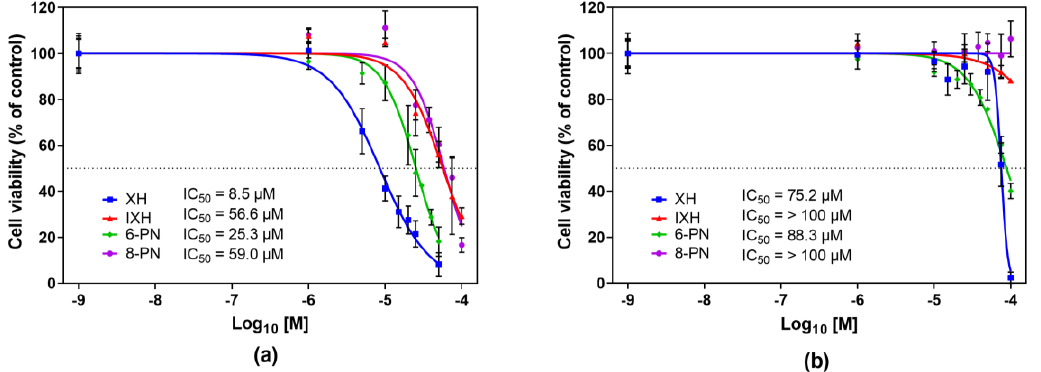
Figure 1. The e ff ect of xanthohumol, isoxanthohumol, 6-prenylnaringenin and 8-prenylnaringenin on the viability of proliferating ( a ) and di ff erentiated ( b ) CaCo-2 cells after a 24 h treatment. Cell viability was assayed using the neutral red uptake assay. Data presented as a percentage of the respective control ( = 100%) represent the mean ± S.D. of 3–4 independent experiments. IC 50 values were calculated using GraphPad Prism 8 software as an average of 3–4 independent experiments.